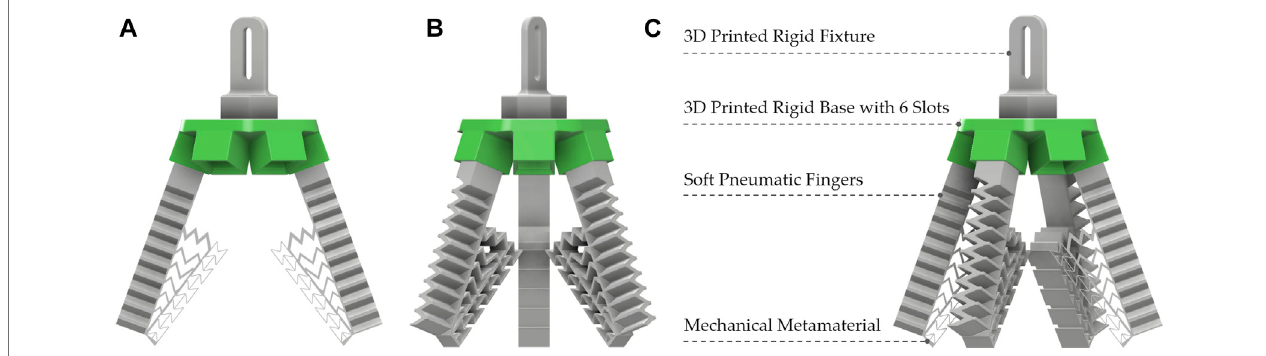
FIGURE1| Themaincomponentsofthe3Dprintedmodularsoftgripperwithintegratedmetamaterial. (A) Two- fi ngercon fi guration. (B) Three- fi ngercon fi guration. (C) Four- fi nger con fi guration.